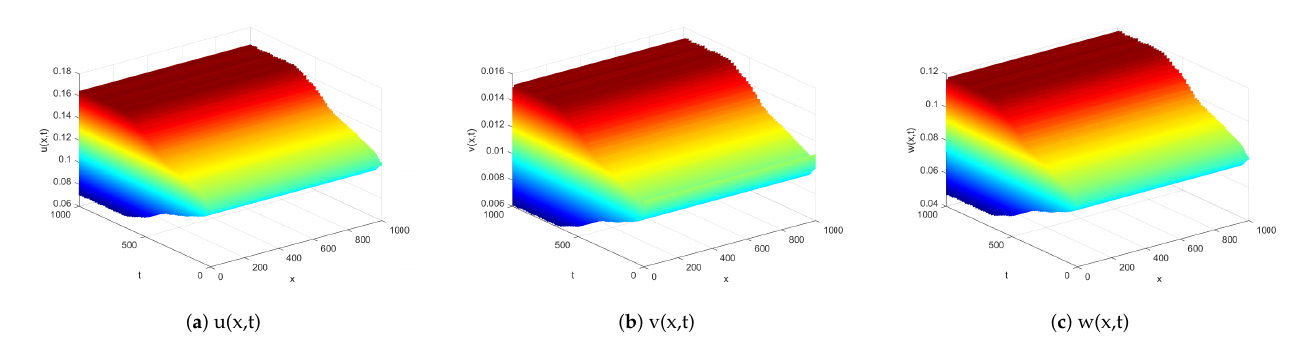
Figure 5. When d 1 = d 2 = d 3 , ( u p ( t ), v p ( t ), w p ( t )) remains stable in system (3).